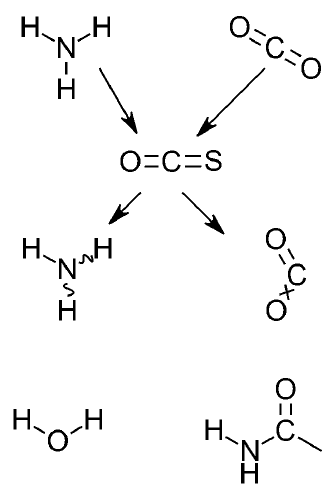
Figure 6. The catalyzed reaction between ammonia and carbon dioxide.